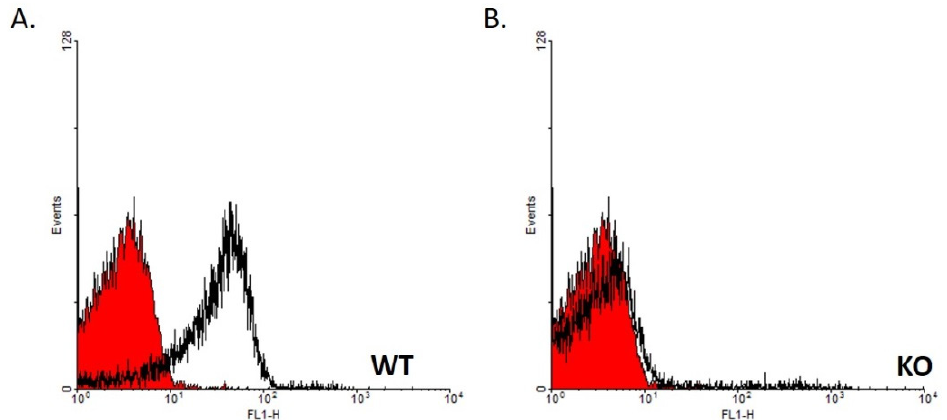
Figure 1. The genotype of the mice was verified by FACS analysis, based on the absence of CD24 expression on the surface of erythrocytes from the KO mice. Heparinized peripheral blood samples of WT ( A ) and KO ( B ) mice were collected and analyzed for CD24 expression. The X -axis (FL1-H) represents florescence magnitude (to the fluorescein isothiocyanate-conjugated goat anti-rat antibody). The red curves represent the negative control (secondary antibody only), and the black curves represent the binding of M1/69 anti-CD24 antibody.